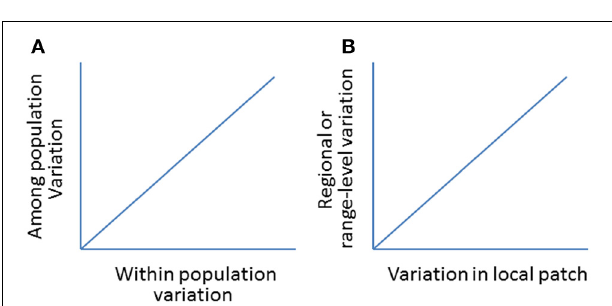
between central and marginal populations over time as the result of spatial synchronization (see also Figure 6 ; for details of the simulation models, see Guo et al., 2005).